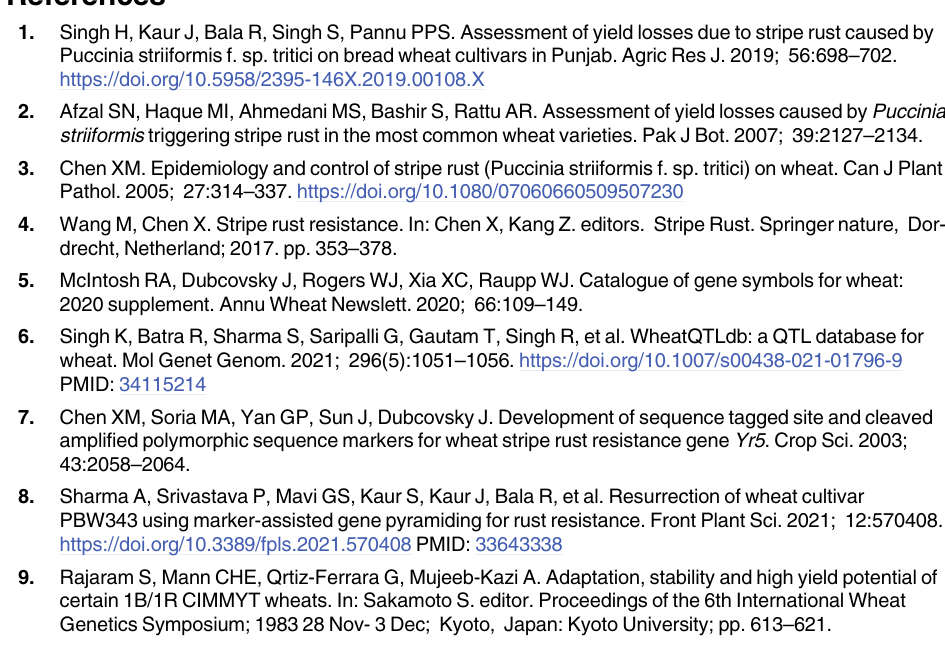
S4 Table. Disease reaction in field nursery and epidemiological parameters on extreme phenotypic category of cross PBW 621 × HD